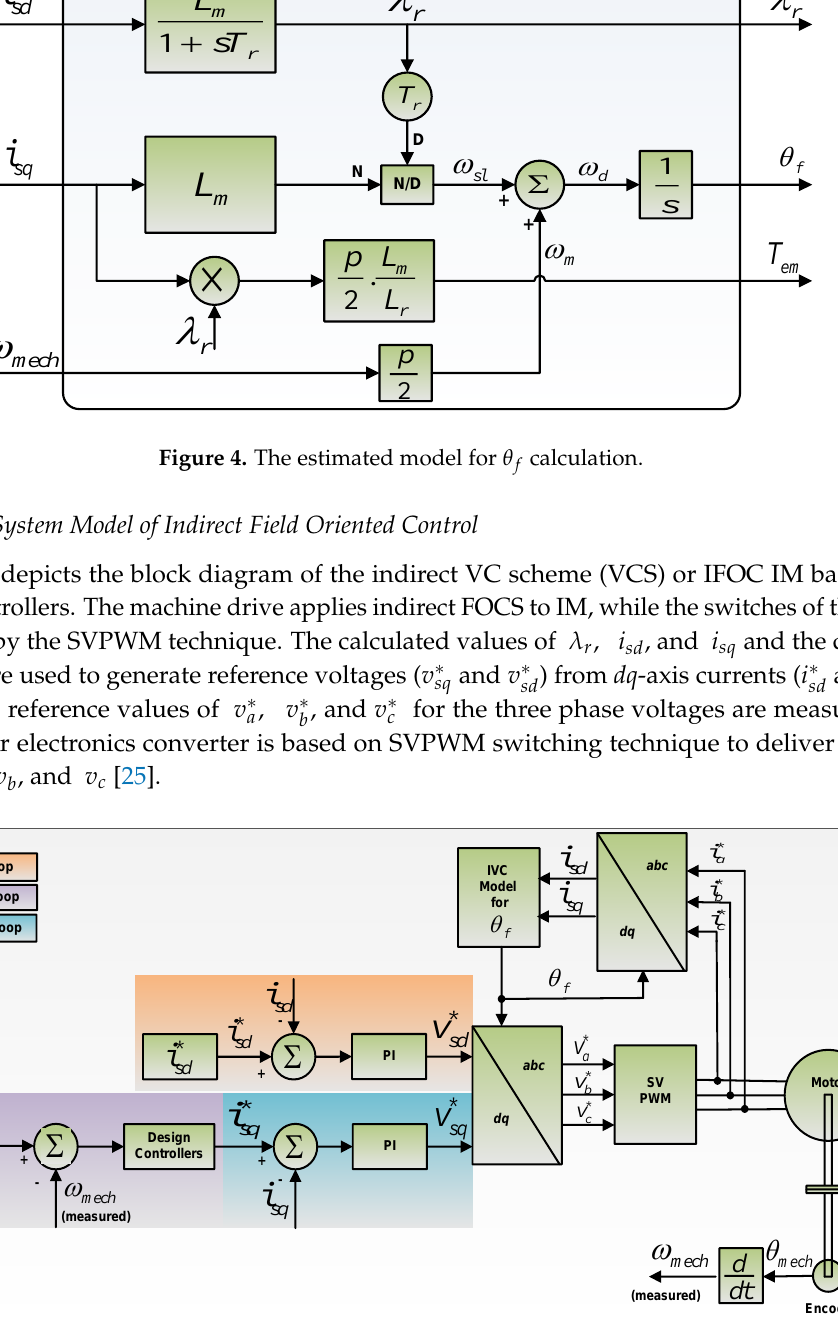
Figure 5. Proposed model of the Indirect Field Oriented Control (IFOC).